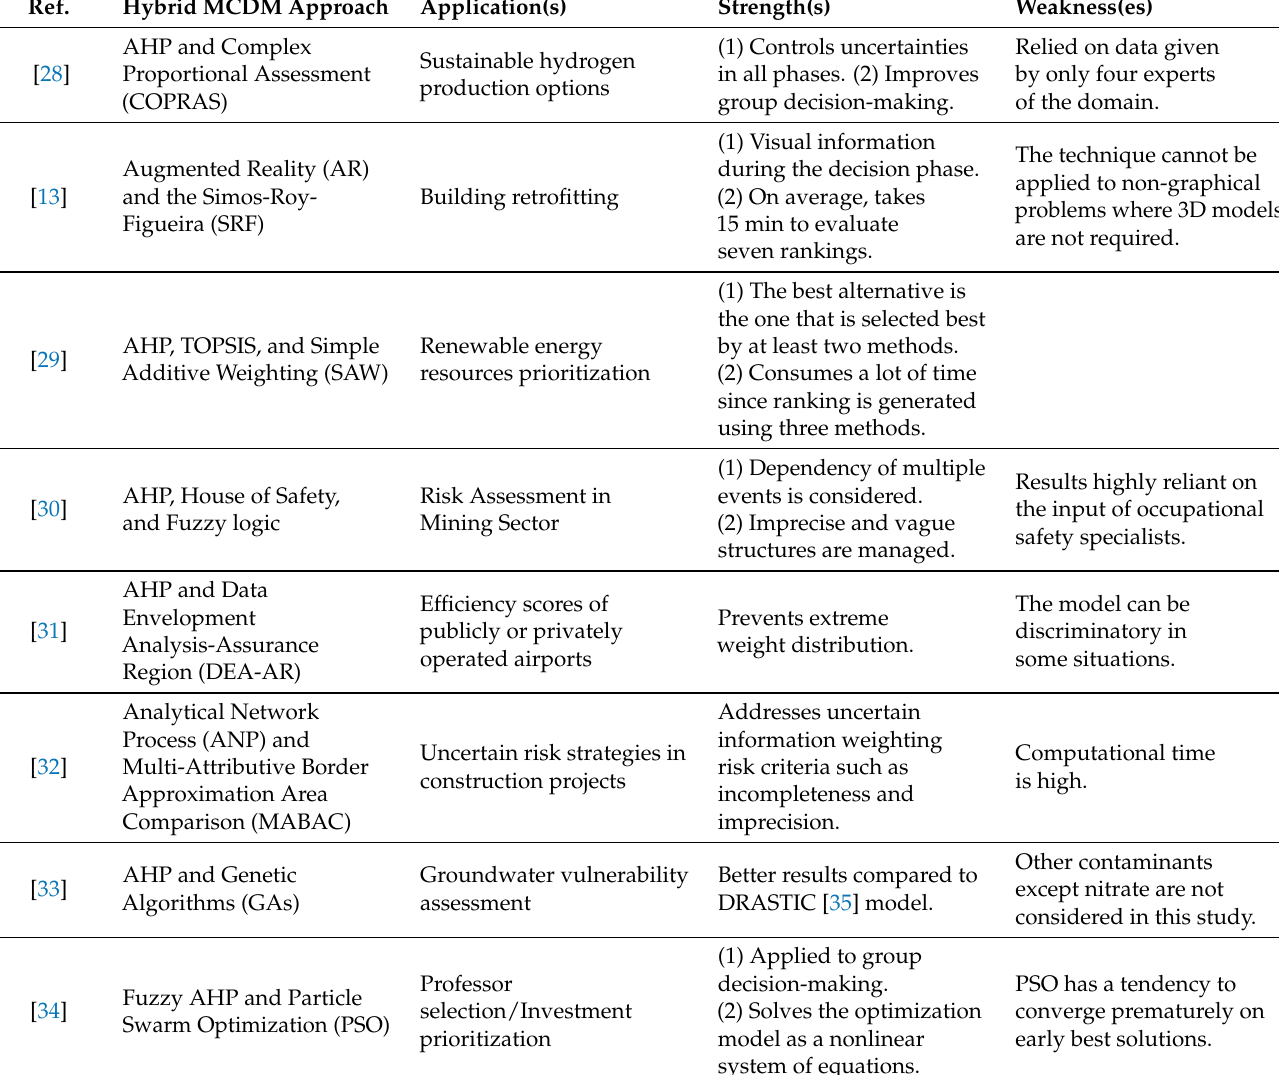
Table 1. Hybrid MCDM approaches and their applications, strengths, and weaknesses.